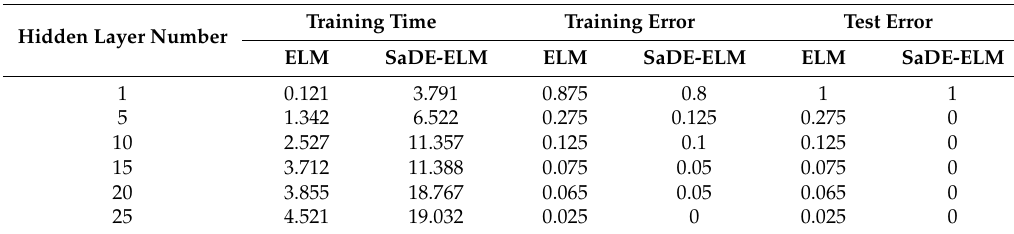
Table 1. Quantity of hidden layer impacts on the